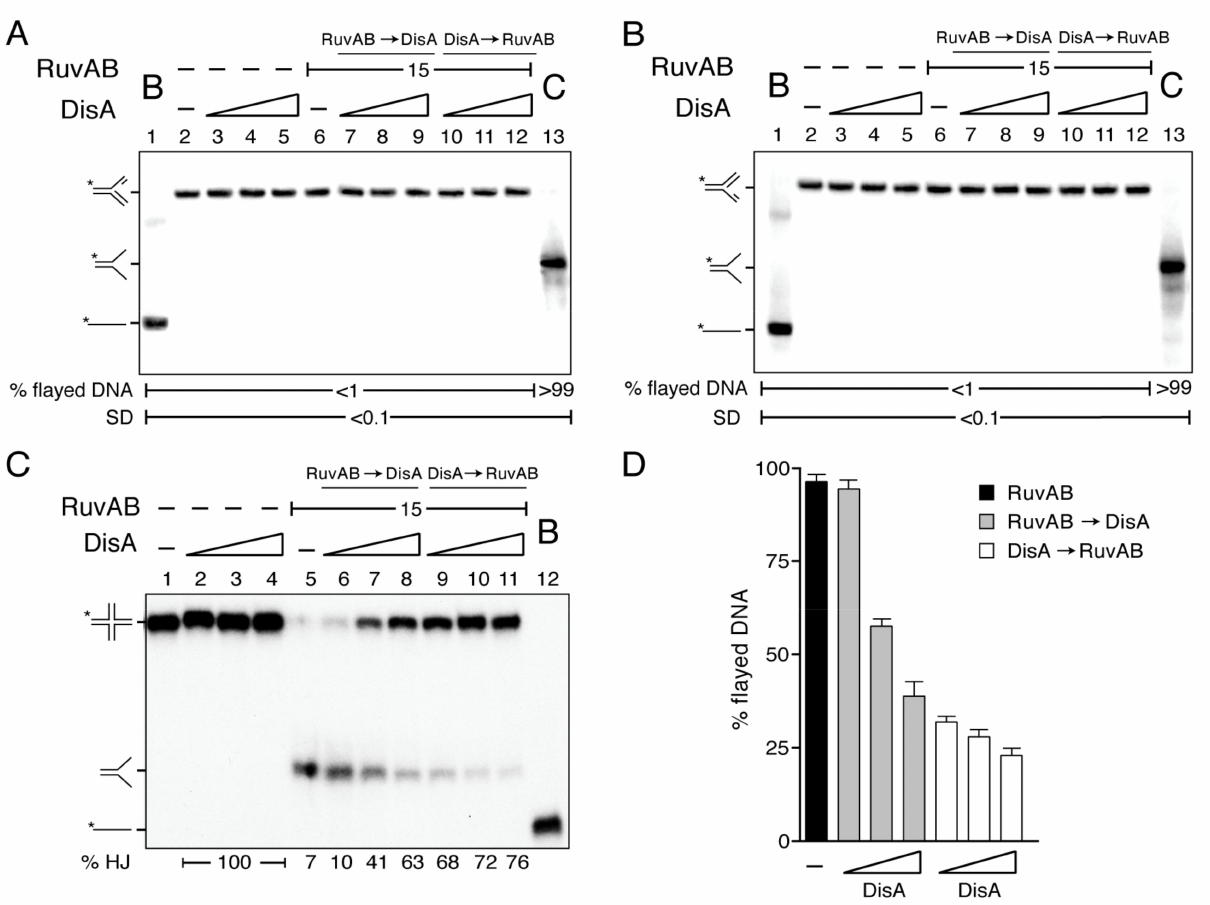
Figure 3. DisA action on RuvAB translocase activity. ( A , B ) RuvAB fails to convert a gapped stalled fork into a reversed one. [ γ - 32 P] forked-Lead ( A ) or [ γ - 32 P] forked-Lag DNA ( B ) was pre-incubated with increasing DisA concentrations (doubling from 12–48 nM) or a fixed amount of RuvAB (15 nM) in buffer C containing 10 mM MgCl 2 (15 min at 37 ◦ C). Then, the second protein (variable DisA [RuvAB → DisA] or a constant amount of RuvAB [DisA → RuvAB]) and 5 mM ATP were added, and the reaction was further incubated (15 min at 37 ◦ C). The reaction was stopped, deproteinized, and separated by 6% native PAGE. -, no protein added; B, boiled forked substrate (lane 1); *, radiolabelled strand; C, expected products of the helicase activity loaded as running position controls. Representative gels are shown. ( C ) DisA inhibits RuvAB-mediated fork restoration. [ γ - 32 P] HJ-J4 DNA was pre-incubated with increasing DisA concentrations or a fixed amount of RuvAB in buffer C containing 10 mM MgCl 2 (15 min at 37 ◦ C). Then, the second protein (variable DisA [RuvAB → DisA] or a constant amount of RuvAB [DisA → RuvAB]) and 5 mM ATP were added, and the reaction was further incubated (15 min at 37 ◦